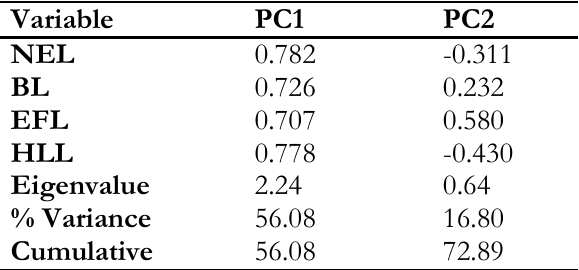
T ABLE 2. Loadings from a Principal Component Analysis of metric characters of Hyla savignyi . Abbreviations: NEL (snout-vent length), BL (length of tail), EFL (head length), HLL (head width).